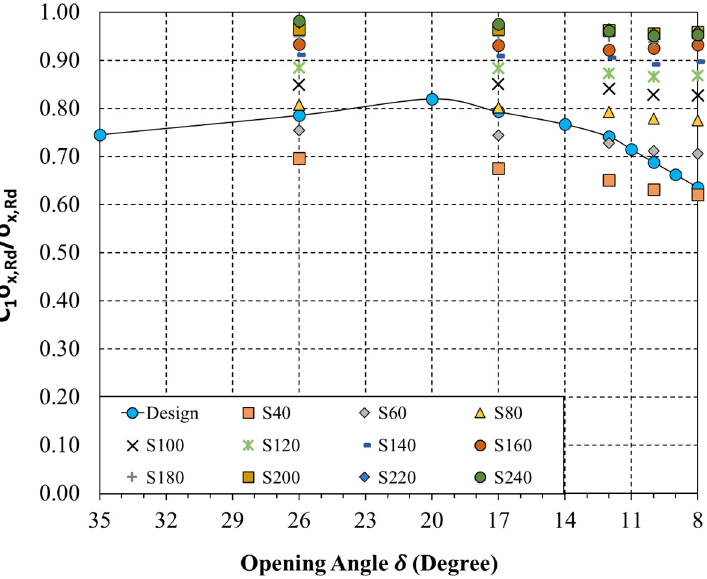
Figure 11. Comparison of analysis results based on design strength and opening angle.